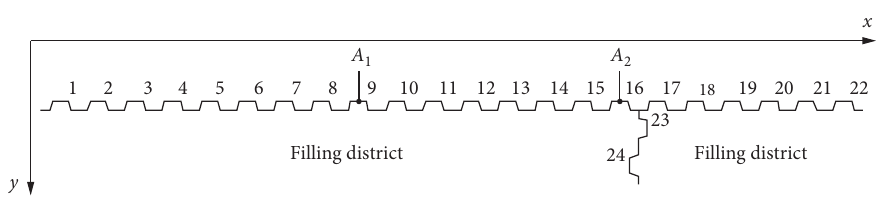
Figure 9: Layout of the piles for Test 3.